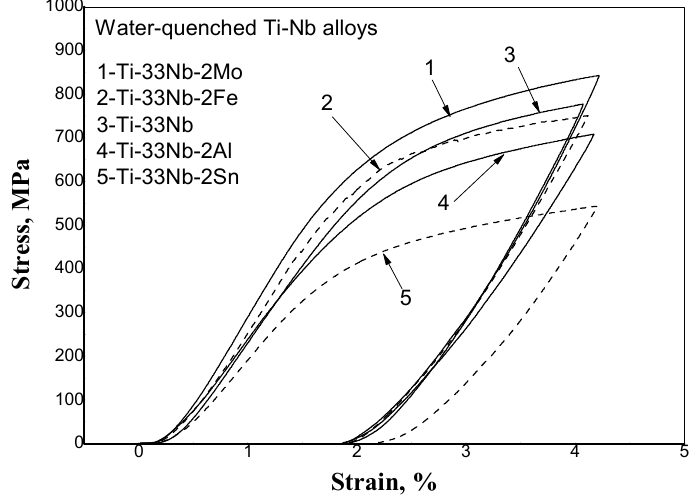
Figure 5. The stress–strain curves of the water-quenched Ti-33Nb-2X (X = Al, Sn, Fe and Mo) alloys. From Table 2, we can see that the addition of 2 wt.% Sn in Ti-33Nb alloy led to a subtle decrease in the Young’s modulus from 41.54 to 40.00 GPa, which is closer to that Table 2. The Young’s modulus of water-quenched Ti-33Nb-2X (X=Al, Sn, Fe and Mo) alloys ob- tained from the compression test.